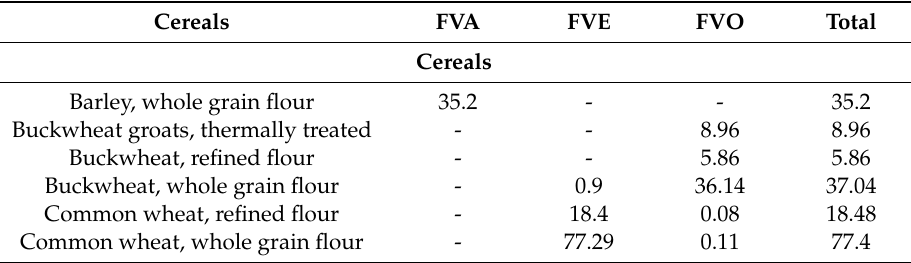
FVA: Flavan-3-ols, FVE: Flavones, FVO: